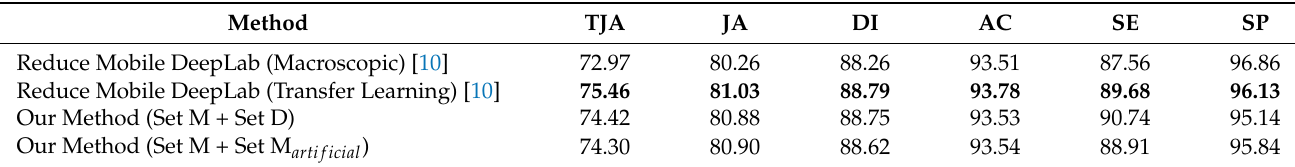
Table 6. Comparison between the proposed methods and related studies using the Dermofit Image Library database. The best result, for each of the metrics in the present table, is identified in